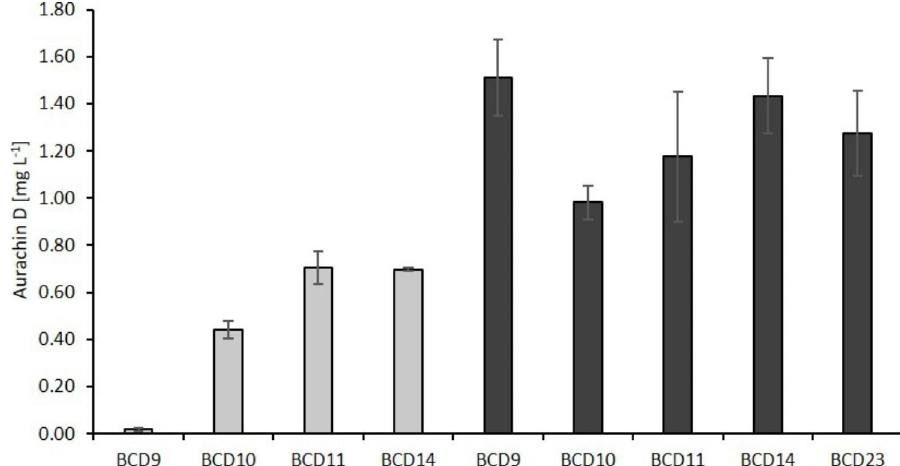
Fig. 5 Production of aurachin D in E. coli cultures expressing auaA _Se (grey bars) and auaA _Sa (black bars) under the control of the trc* promoter using different BCD